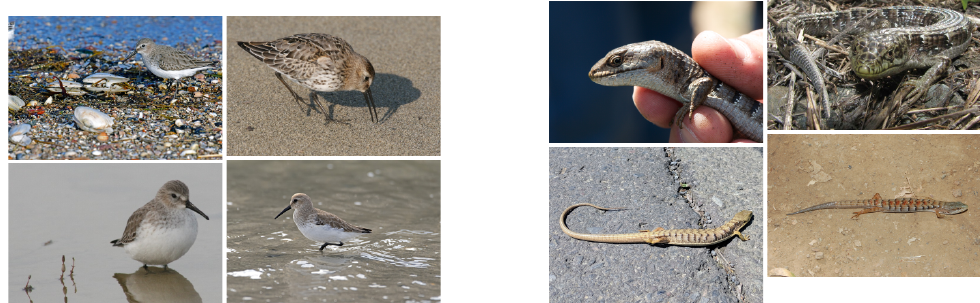
Figure 1. Samples of <dunlin> and <alligator lizard> . By the affordances <dunlin> is different from <alligator lizard> as they are different species. By the visual information, they have similar color and texture. The experiments showed humans will label images into semantically different categories, but AlexNet CNN, trained on ImageNet dataset [11], would misclassify <dunlin> as <alligator lizard> . <alligator lizard> photos by Jerry Kirkhart, California Department of Fish and Wildlife, and Greg Schechter licensed under CC BY 2.0 and by Eugene Zelenko licensed under CC BY-SA 2.0.